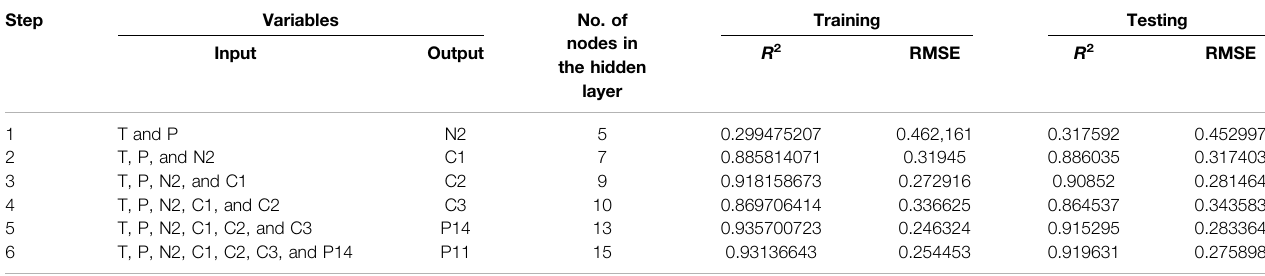
TABLE 9 | Optimum value of H n calculated for the cascaded ANN model given in Table 6 .